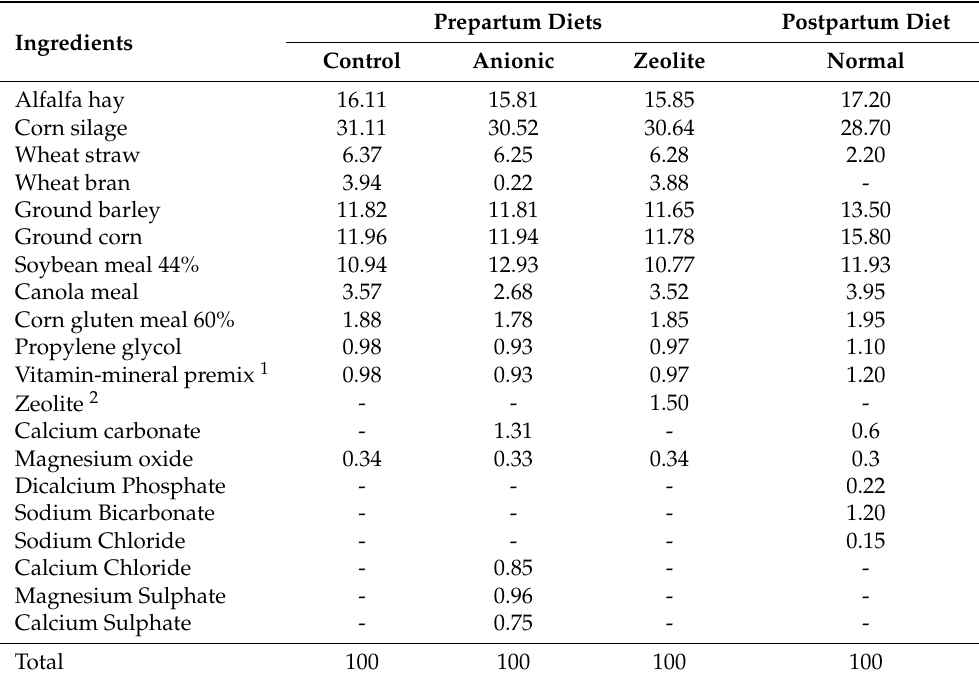
Table 1. Feed ingredients of the experimental diets before and after parturition (% of DM unless otherwise